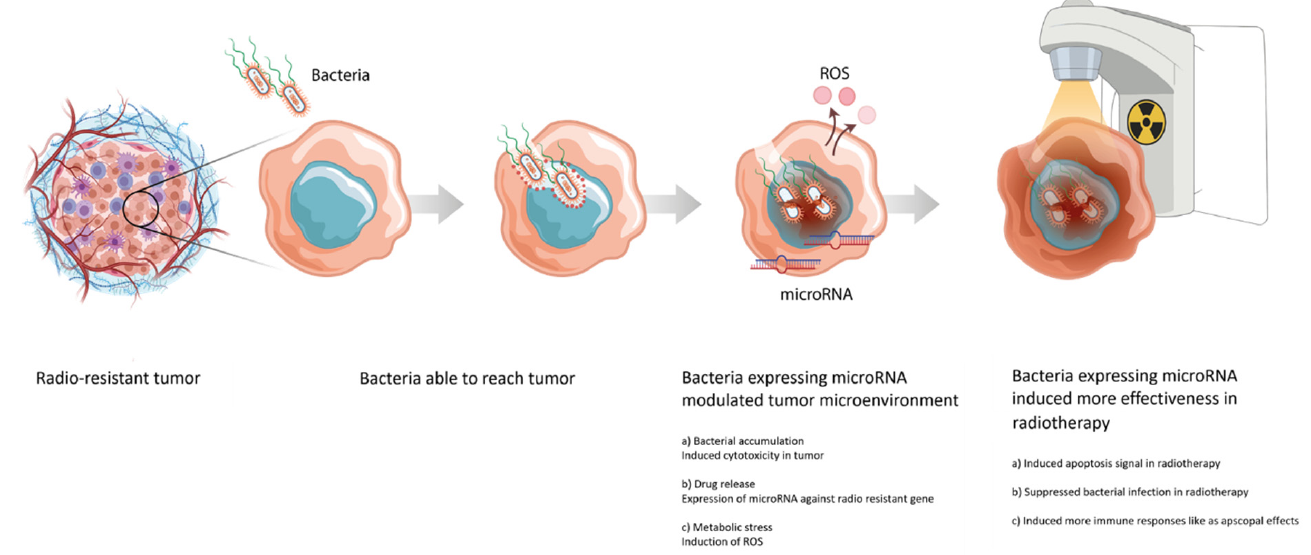
Figure 1. Application of bacterial treatment for combined radiation therapy.